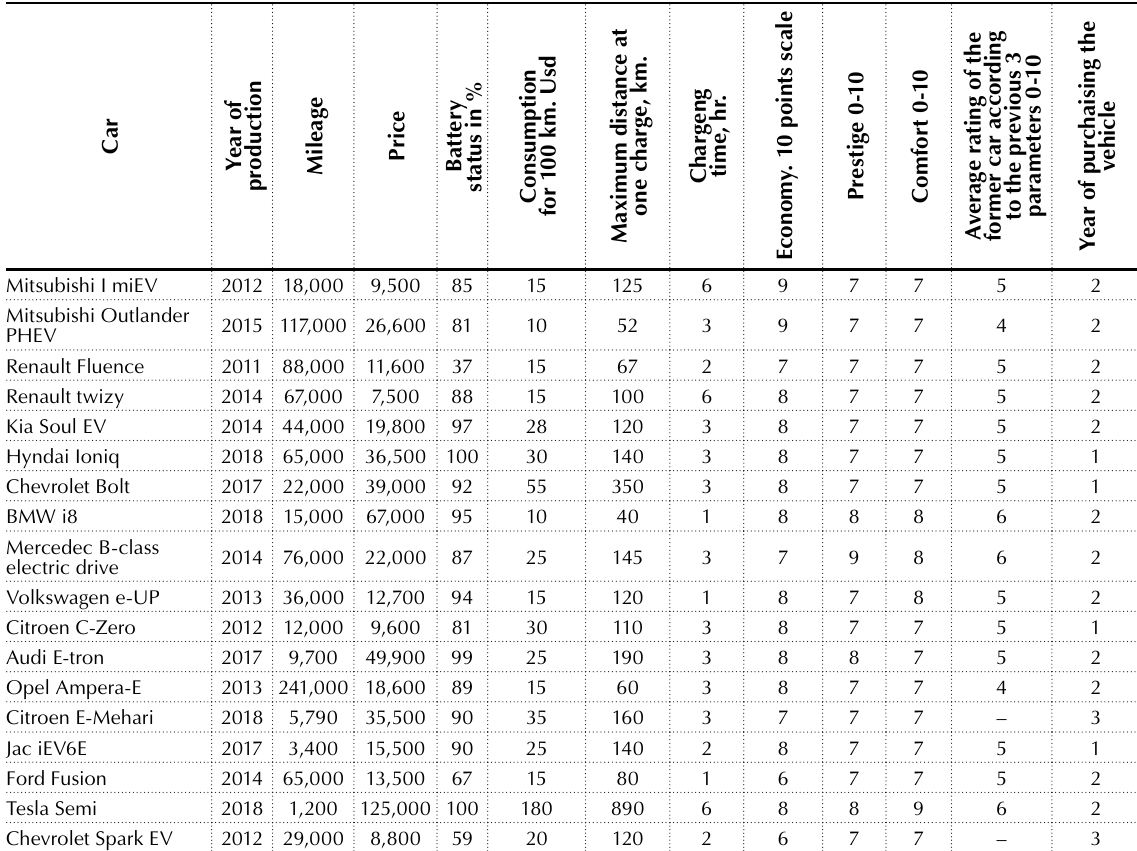
Table 1 (cont.). Statistics of input data of technical parameters and comparative characteristics of key parameters of electric